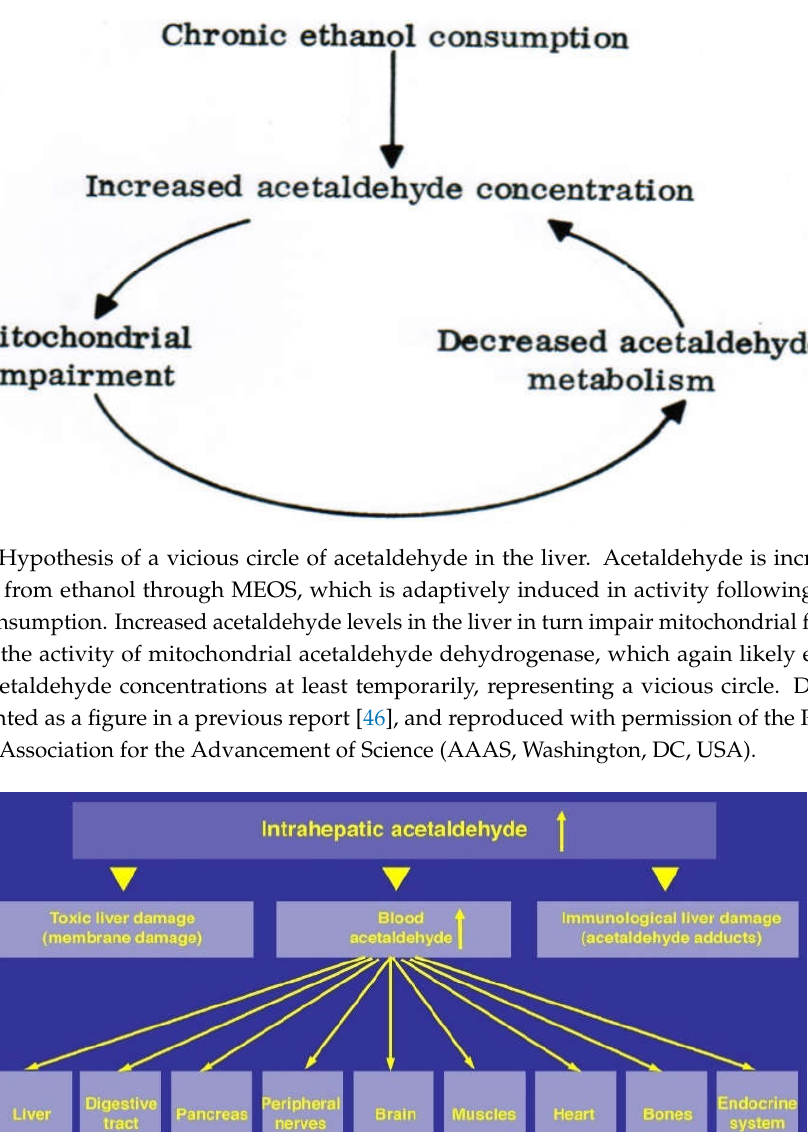
Figure 7. Actions of acetaldehyde. The increasingly generated acetaldehyde in the liver spills over in the blood and reaches many organs, which are injured by direct toxic attacks or through condensation products. Alcohol dependence is considered to be triggered by the condensation of acetaldehyde with dopamine or serotonin. Symbol ↑ : Increase.